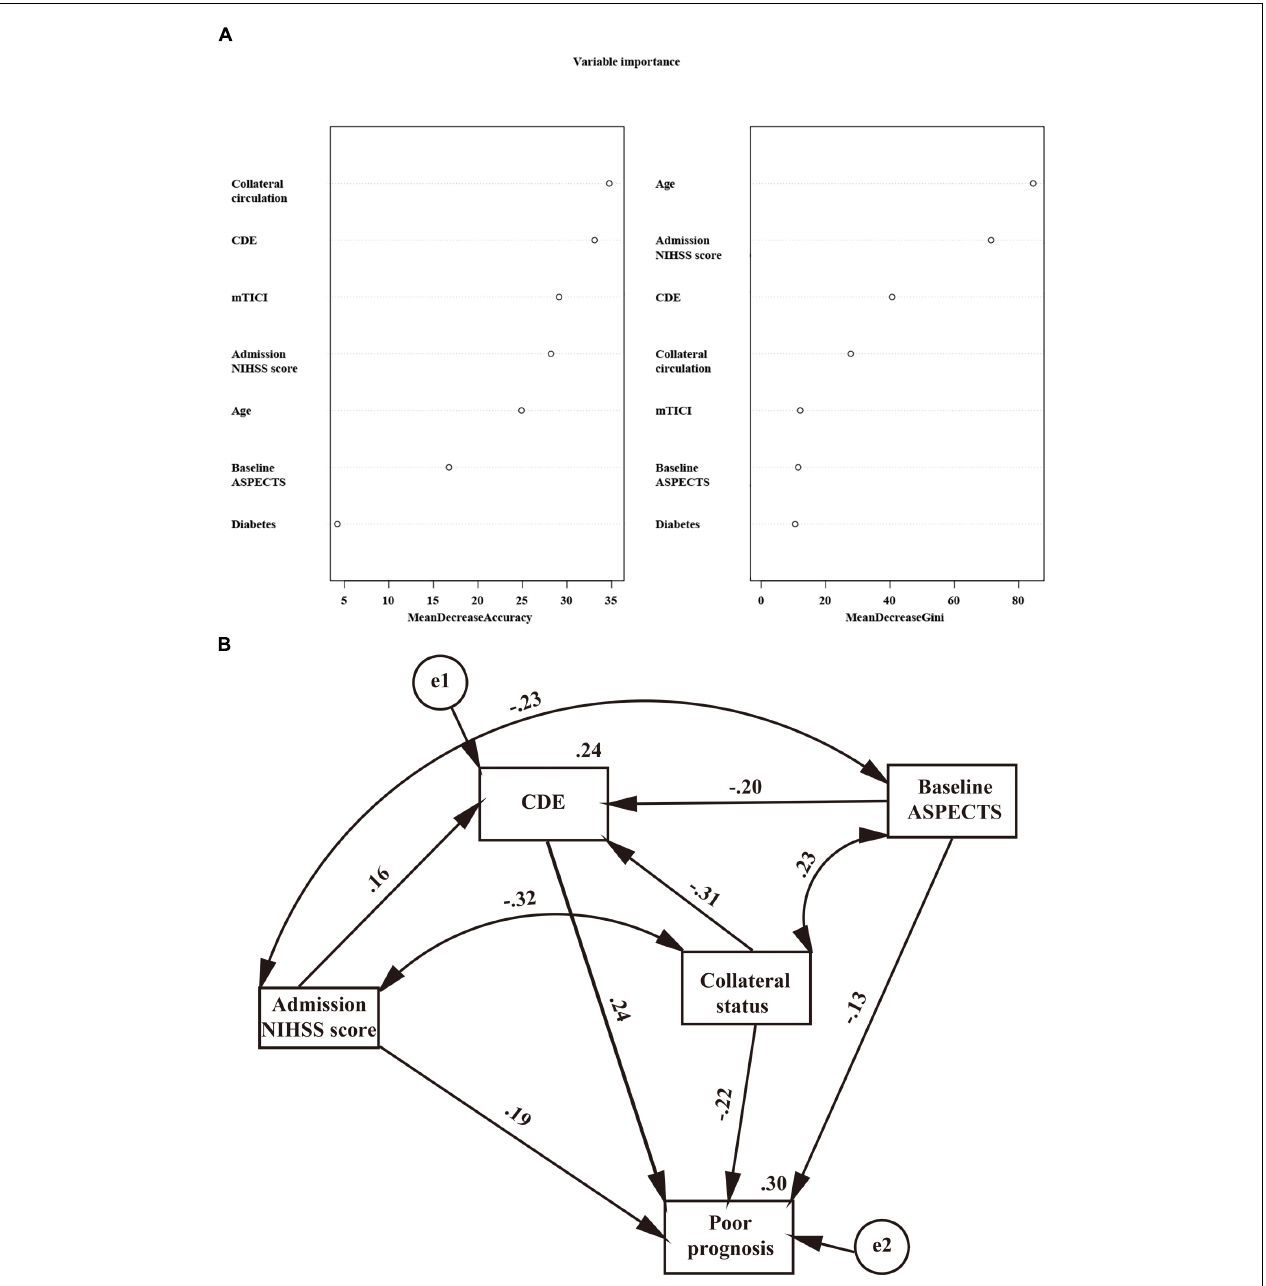
FIGURE 2 | (A) Importance values of clinical variables. MeanDecreaseAccuracy indicates a decrease in accuracy after variable substitution; MeanDecreaseGini indicates a decrease in the Gini coefficient after variable substitution. A higher value indicates that the variable is more important. (B) Regressions from the structural equation model on the relationship of the admission NIHSS, baseline ASPECTS, collateral status, and CDE with a poor prognosis. Standardized coefficients are presented; all P <